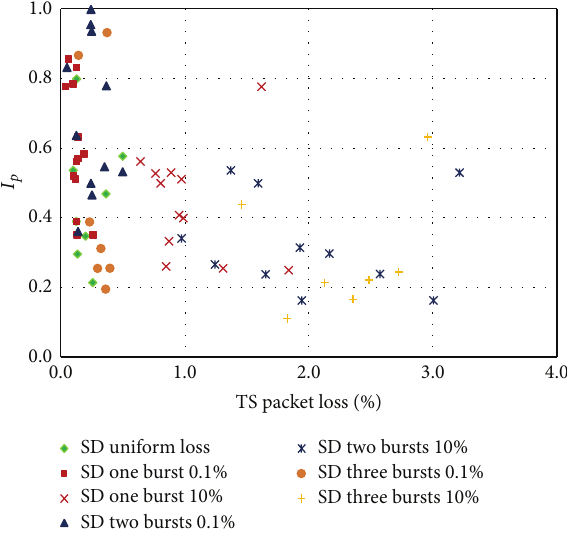
Figure 4: 𝐼 𝑝 versus percentage of TS packet loss for SD